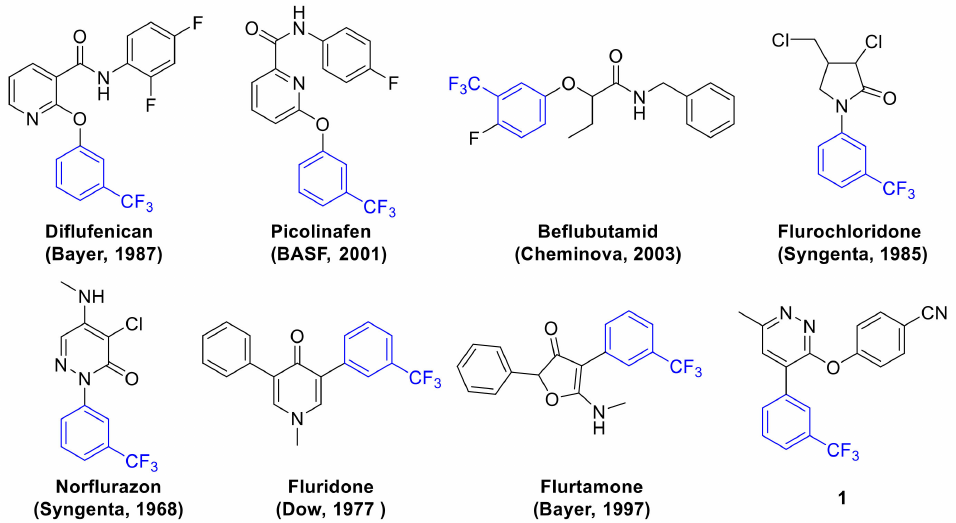
Figure 1. The chemical structures of commercial PDS inhibitory herbicides and the lead compound 1 . The introducing company and year are shown below each herbicide; the common sub-structure of the herbicides and compound 1 are highlighted in